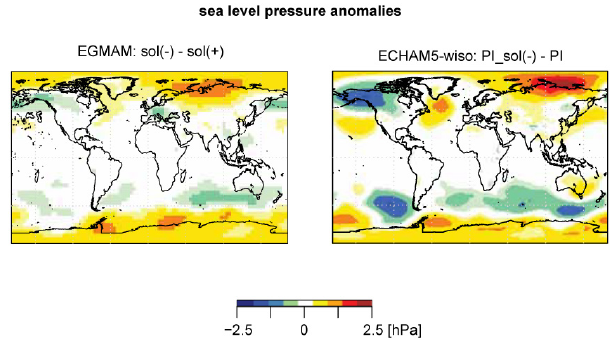
Fig. 12. The simulated annual mean sea level pressure pattern (SLP) of (a) the EGMAM experiment (after Spangehl et al., 2009) and (b) the corresponding ECHAM5-wiso simulations. Shown are the anomalies between a phase with low solar activity, sol( − ), and a phase of default solar activity. This is the sol( + ) phase in the case of EGMAM, which is derived from a period with pre-industrial con- ditions (see Sect. 2.2), and the pre-industrial climate (PI) in the case of